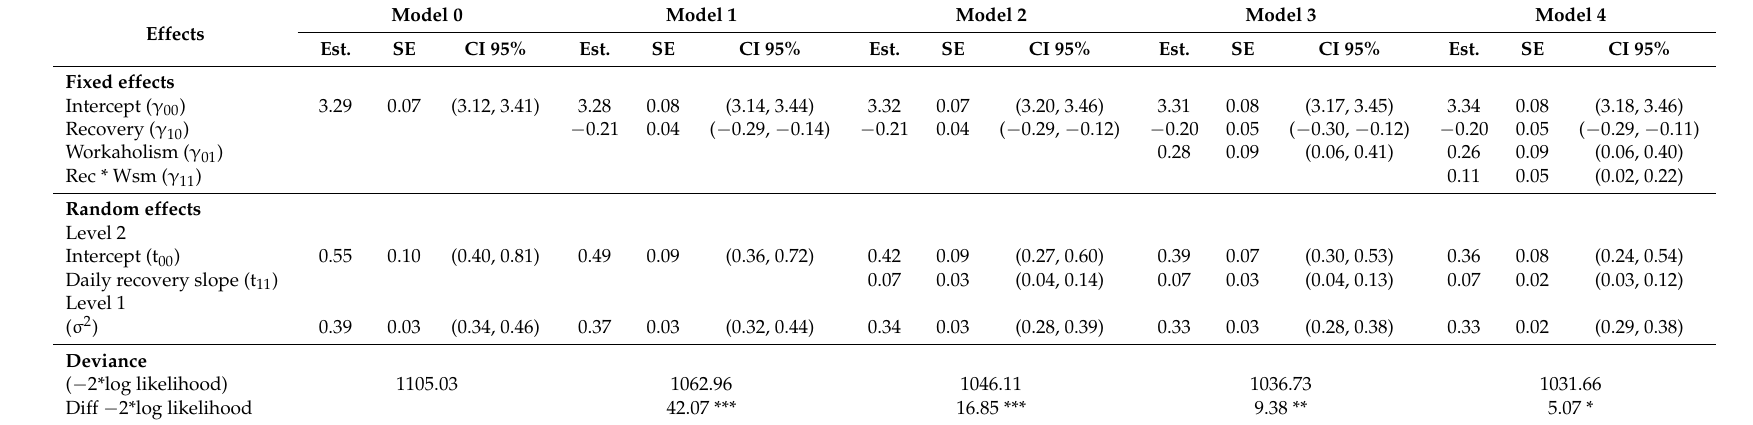
Table 2. Results of multilevel structural equation modeling predicting day-level exhaustion (unstandardised